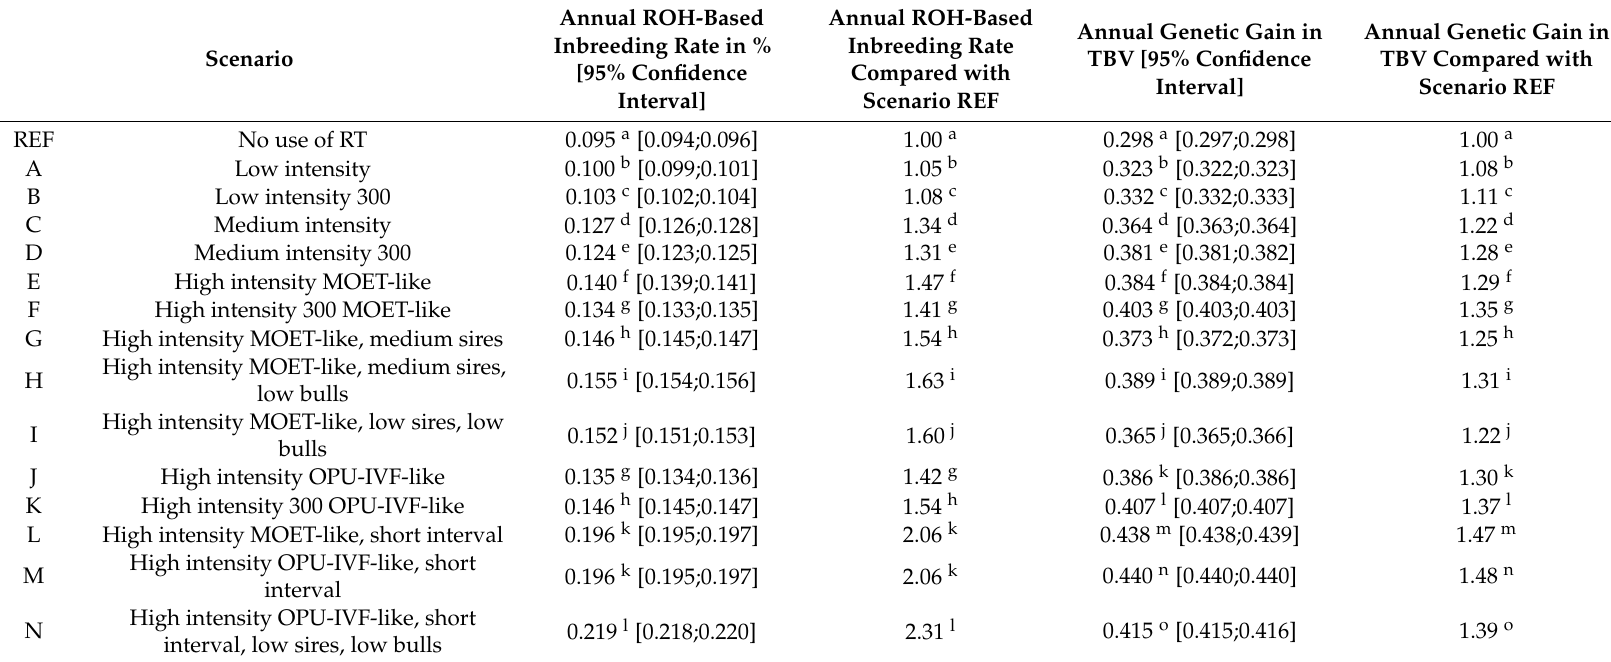
Table 2. Annual runs of homozygosity (ROH)-based inbreeding rate versus annual genetic gain among cows.